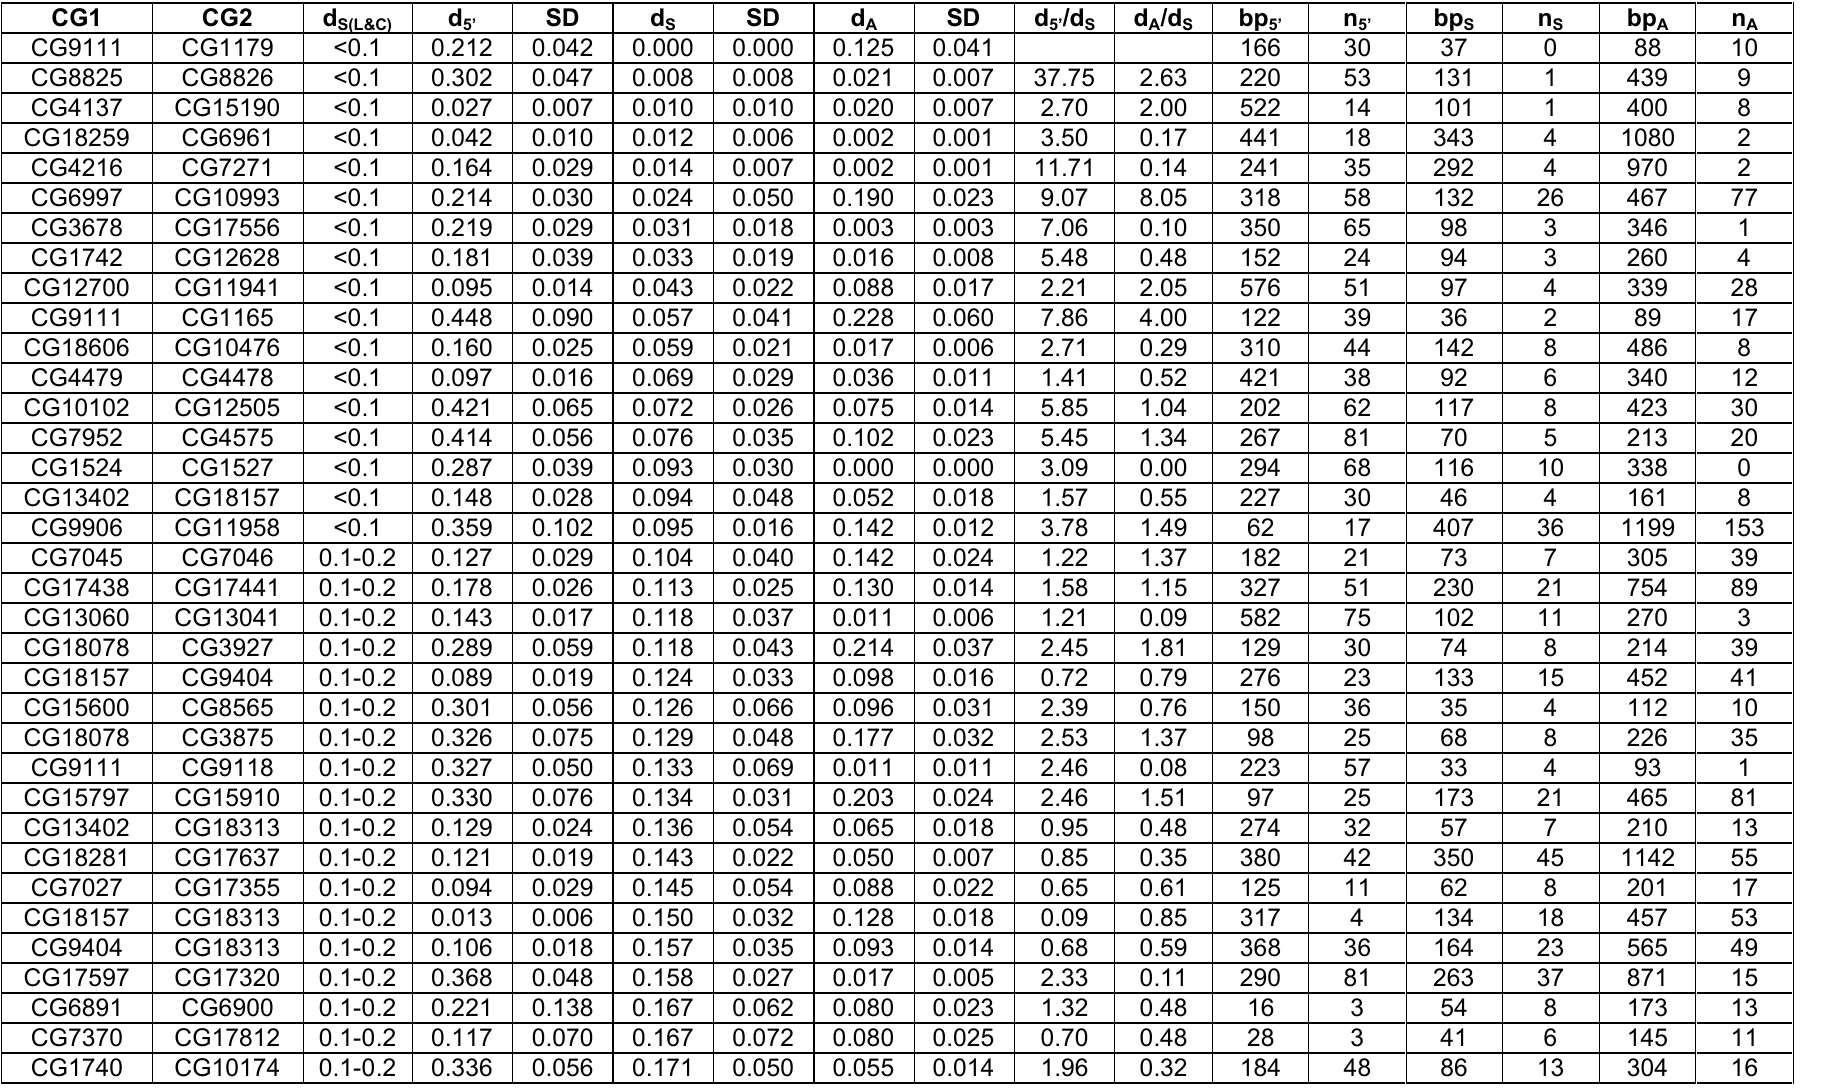
, re-calculated d , d , and d and their respective 1 standard S(L&C) 5’ S A /d and d /d . Furthermore, given are the number sites examined in the 5 prime region, 5’ S A S , bp , bp ) and the number of sites divergent between gene pairs (n 5’ S A